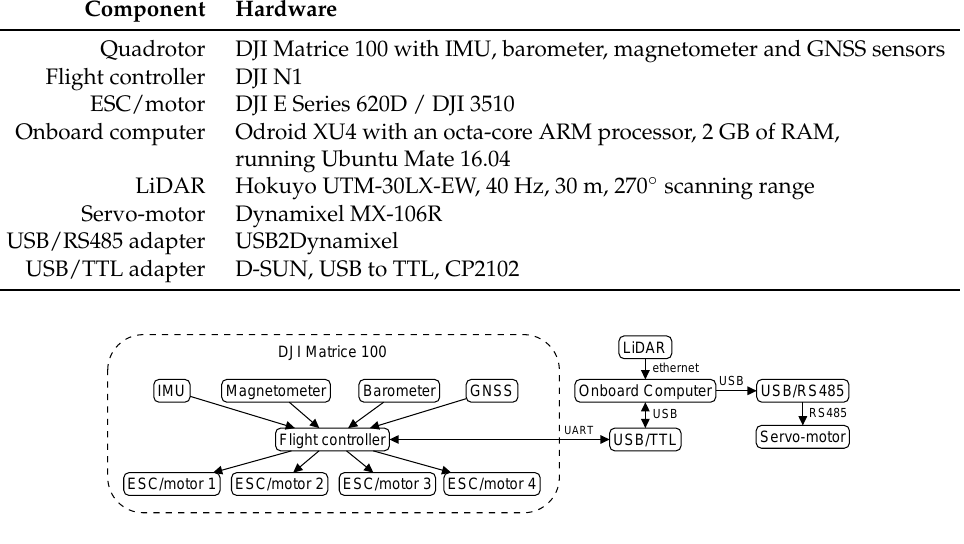
Figure 8. Experimental setup diagram.